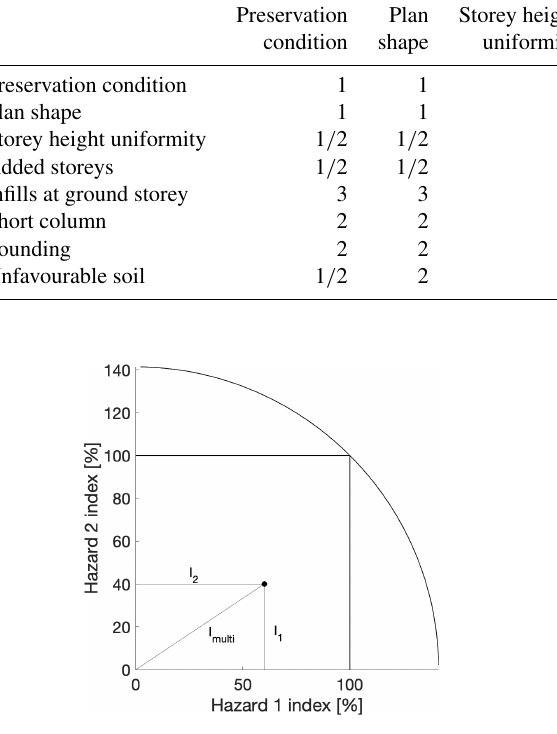
Figure 3. Definition of a two-dimensional ( k = 2) multi-hazard in-